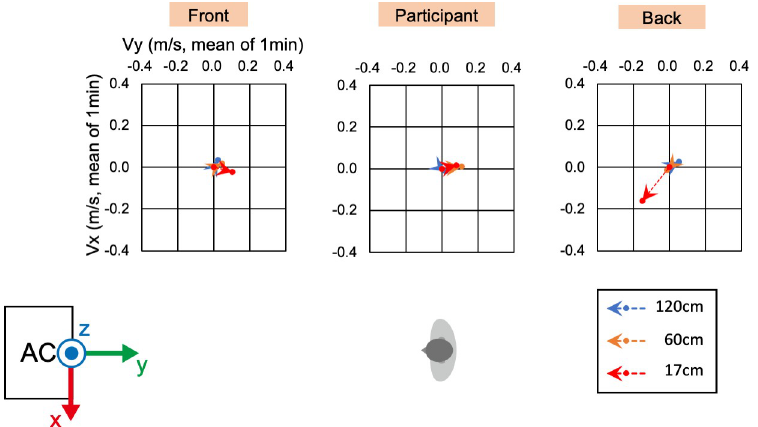
Fig 6. Wind velocity and direction in the X-Y plane of the indirect condition. Vx and Vy indicate the mean of the 1-min velocity in the Y or Z direction, respectively. Dotted lines indicate the vectors of the wind velocities.